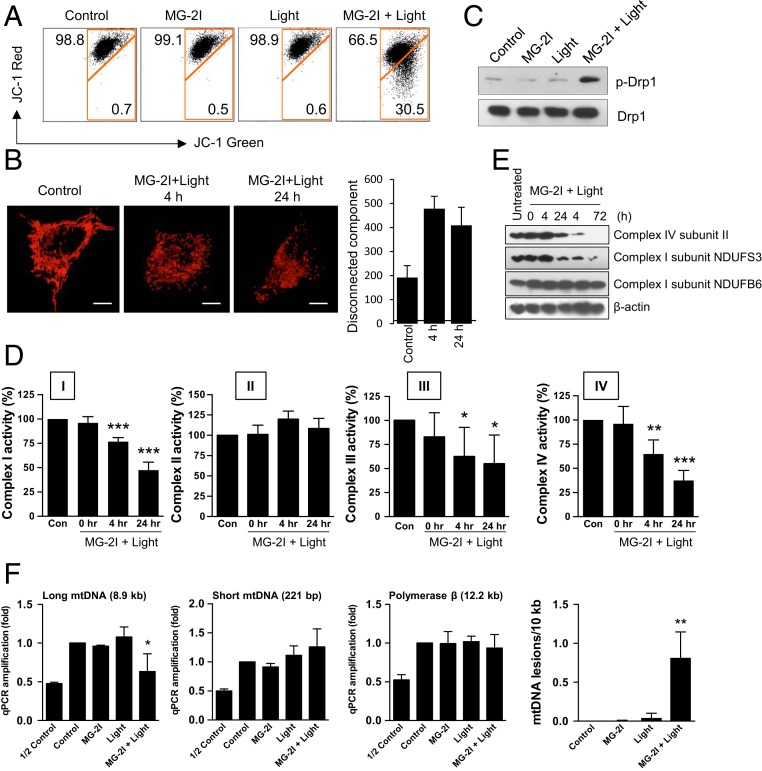
Characterization of mitochondrial damage induced by mitochondrial singlet oxygen generation through Mito-FAP. (A) HEK293 Mito-FAP cells were treated with MG-2I dye (50 nM) alone, light exposure (660 nm, 5 min) alone, or light exposure (660 nm, 5 min) in the presence of 50 nM MG-2I. The mitochondrial membrane potential was assessed by a membrane potential indicator JC-1 24 h after treatment. The loss of JC-1 red fluorescence after MG-2I and light treatment indicates the shift from JC-1 dimer to JC-1 monomer and hence, the loss of mitochondrial membrane potential. (B) At 4 and 24 h after treatment with 50 nM MG-2I and light (660 nm, 5 min), mitochondrial morphology was visualized by staining cells with Tom20 and Alexa 555-conjugated secondary antibody. Mitochondrial connectivity was quantified by reconstructed 3-dimensional images using Imaris software. (Scale bars: 5 μm.) (C) Phosphorylation of Drp1 was determined by western blot 24 h after treatment as indicated. (D) HEK293 Mito-FAP cells were treated with or without the combination of MG-2I (50 nM) and light (5 min). For the determination of ETC complex activities, cells were harvested right after treatment (0 h) or after 4 and 24 h of recovery. Data represent mean ± SEM of at least 3 independent experiments. *P < 0.05; **P < 0.01; ***P < 0.001. (E) Changes in the protein levels of several subunits of ETC complexes were evaluated by western blot at the indicated time points after MG-2I (50 nM) and light (5-min) treatment. (F) HEK293 Mito-FAP cells were treated with MG-2I dye (50 nM) alone, light exposure (660 nm, 5 min) alone, or light exposure (660 nm, 5 min) in the presence of 50 nM MG-2I. The damage of mtDNA and nuclear DNA was analyzed by a long-range qPCR DNA lesion assay 24 h after treatment. The PCR amplification of a large mtDNA segment (8.9 kb), a small mtDNA segment (221 bp), and the gene of polymerase β (12.2 kb) was performed. The inclusion of the measurement of amplification with a template DNA amount that is half of the amount used in control group indicates that the amount of PCR product corresponds to the starting amount of template DNA. Data represent mean ± SEM of 3 independent experiments with 3 PCR reactions per treatment condition. *P < 0.05 (one-way ANOVA); **P < 0.01 (one-way ANOVA).